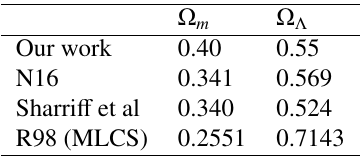
Table 1: Comparison of our best fit values of Ω m and Ω Λ against literature values